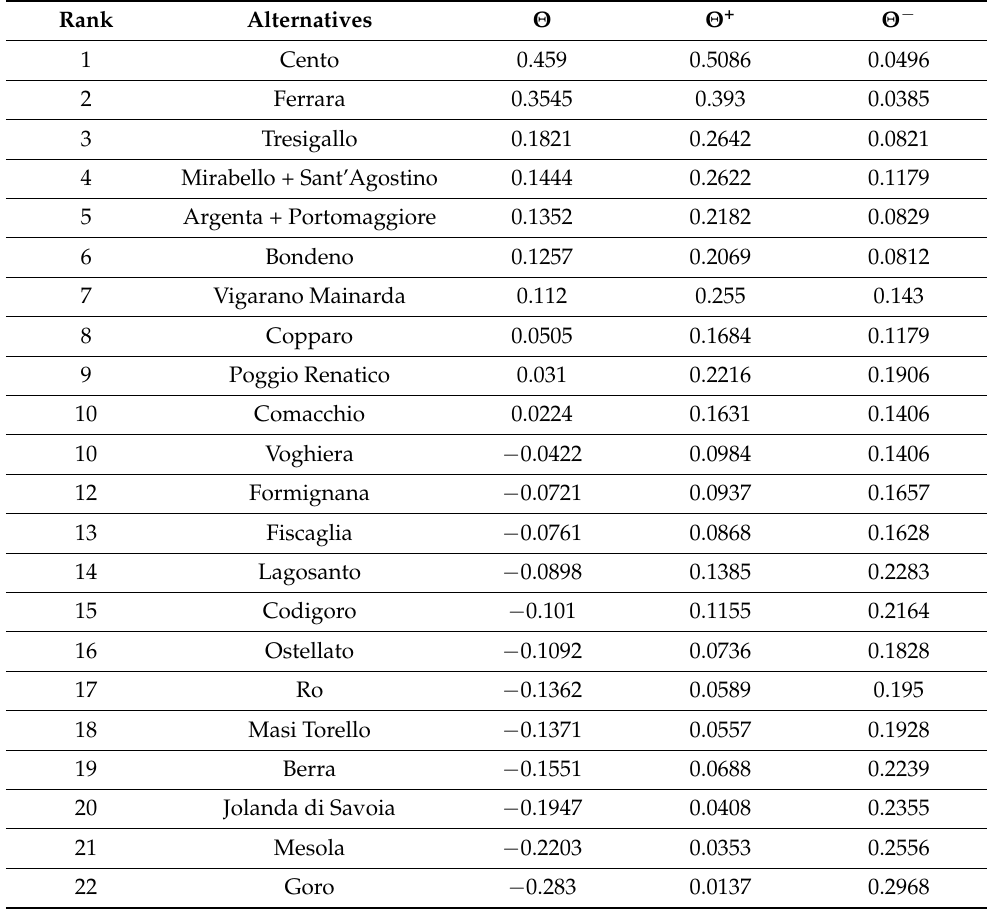
Table 5. Ranking of alternatives for the linear preference function and zero-max